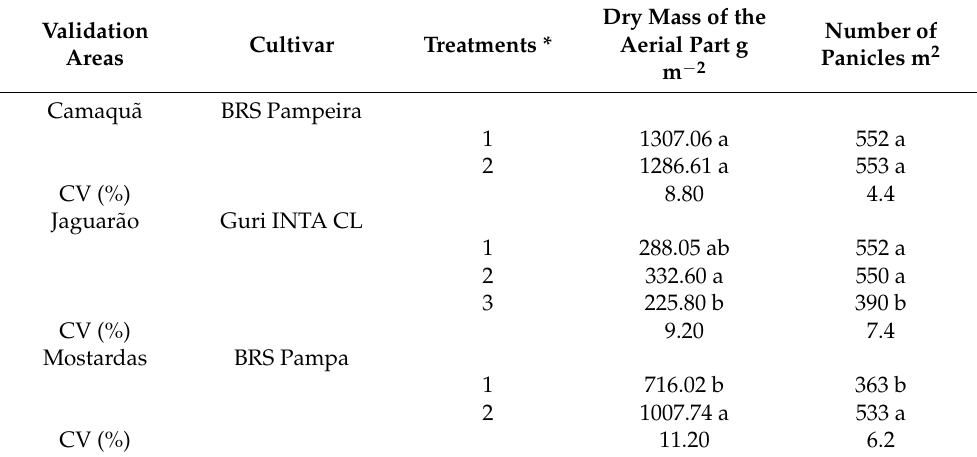
Table 10. Dry mass production and the number of panicles of rice plants as a function of treatments in three validation areas Means of three